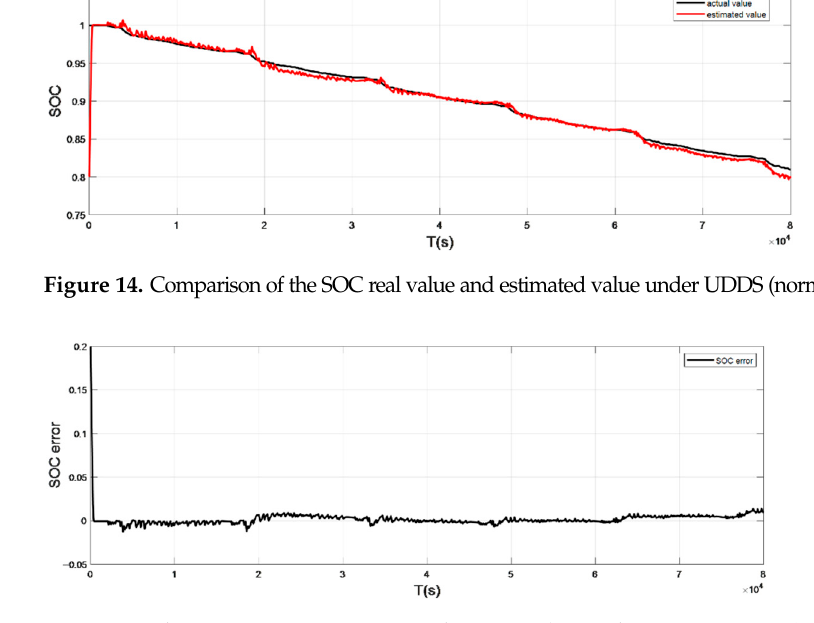
Figure 15. The SOC estimation error under UDDS (normal temperature: 25 °C).